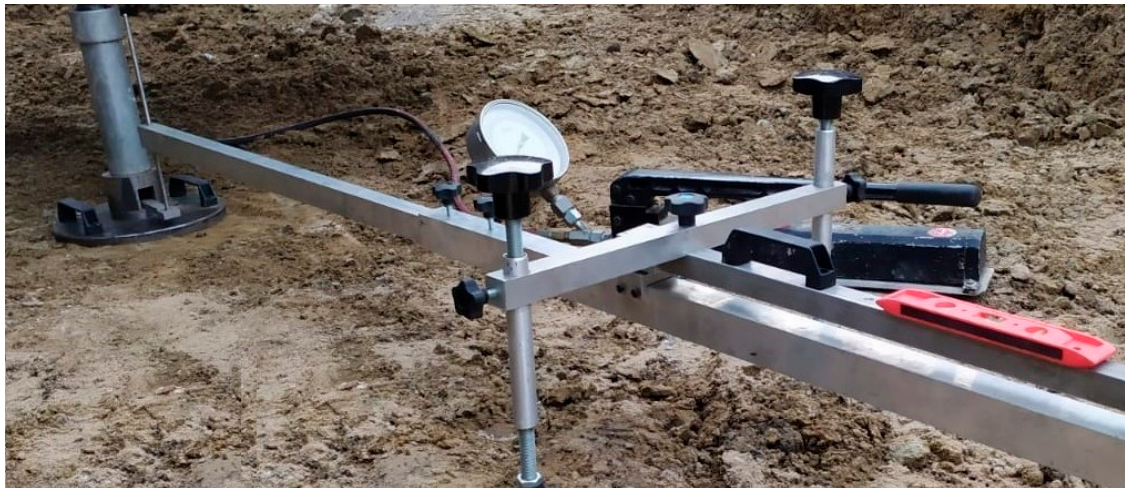
Figure 4. The in-situ plate load test system used in the experiment.